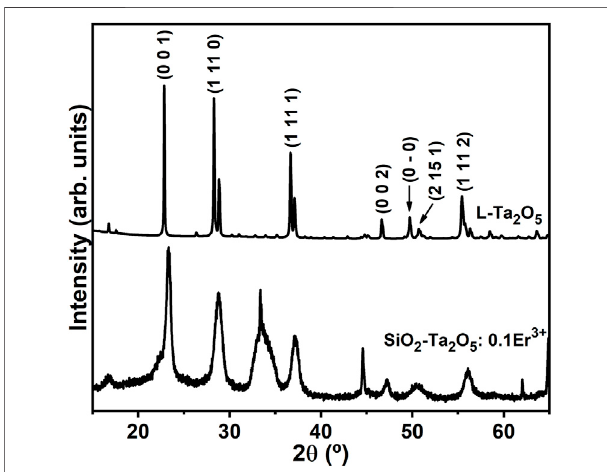
FIGURE 3 | Powder XRD patterns of the 0.1 mol% Er 3+ -doped SiO 2 - Ta